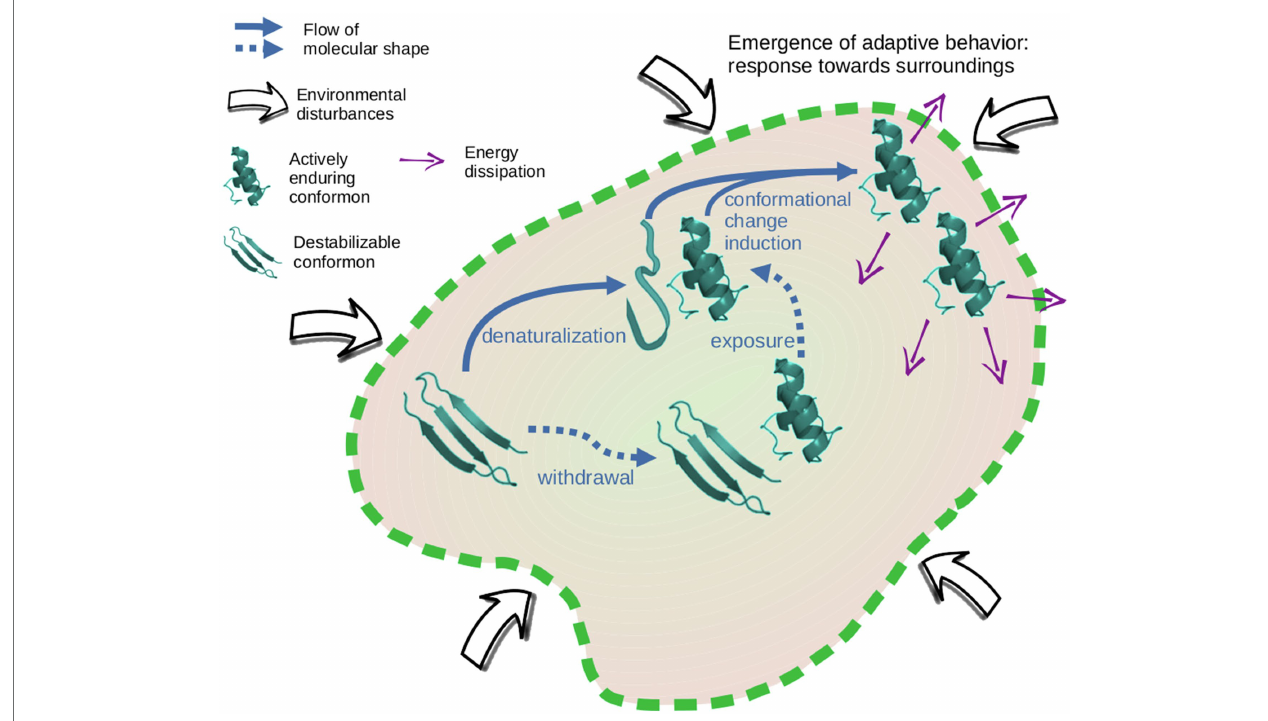
FIGURE 2 | Structuring adaptive prebiotic systems through the conformational information. The flow of conformational information between clusters permits the structuring of a dynamical scaffolding that supports system interactions with surroundings in an emergent adaptive